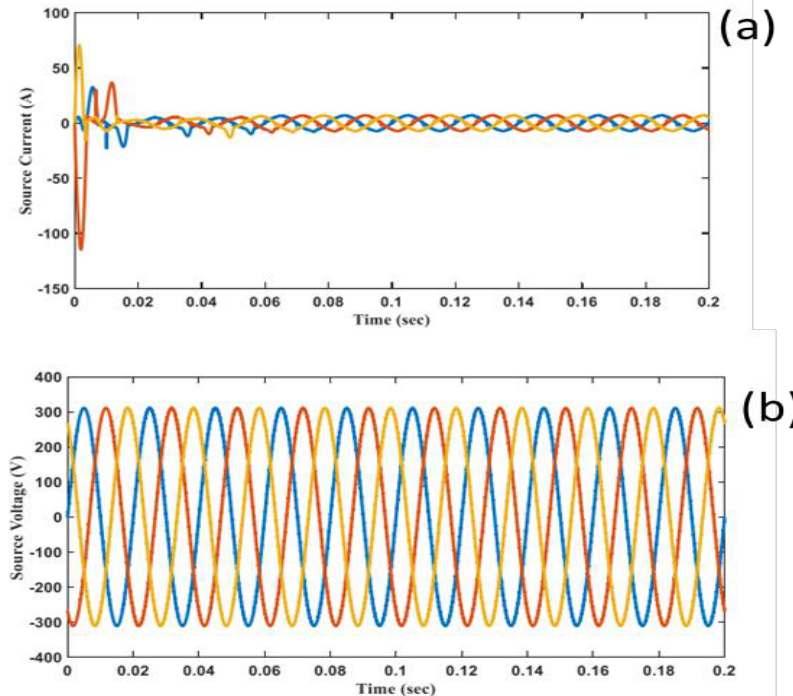
Figure 28. ( a ). Source Current ( b ). Source Voltage (with Simulated ANN Based Filter).